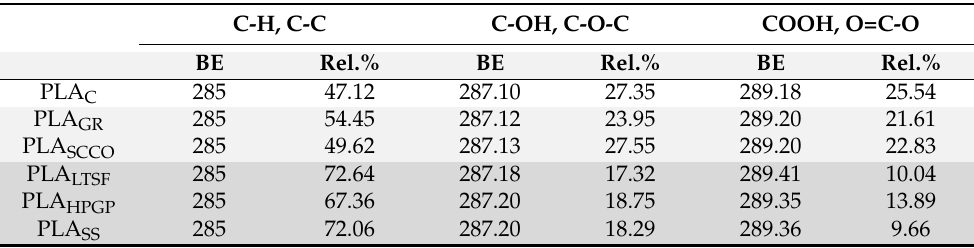
Table 4. Carbon binding energy (BE) assignments with relative percentage (rel.%) from high resolu- tion XPS spectra of untreated PLA and PLA after sterilisation treatments.